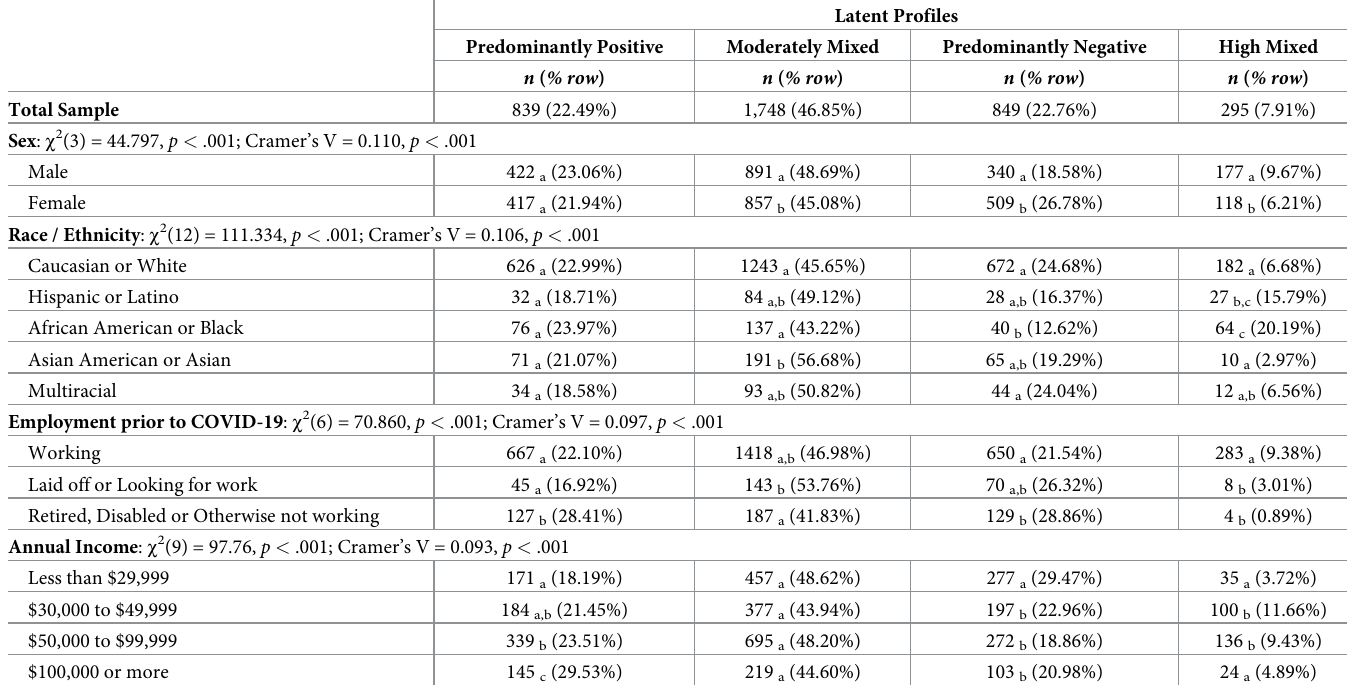
Table 4. Demographics of the four latent profiles.